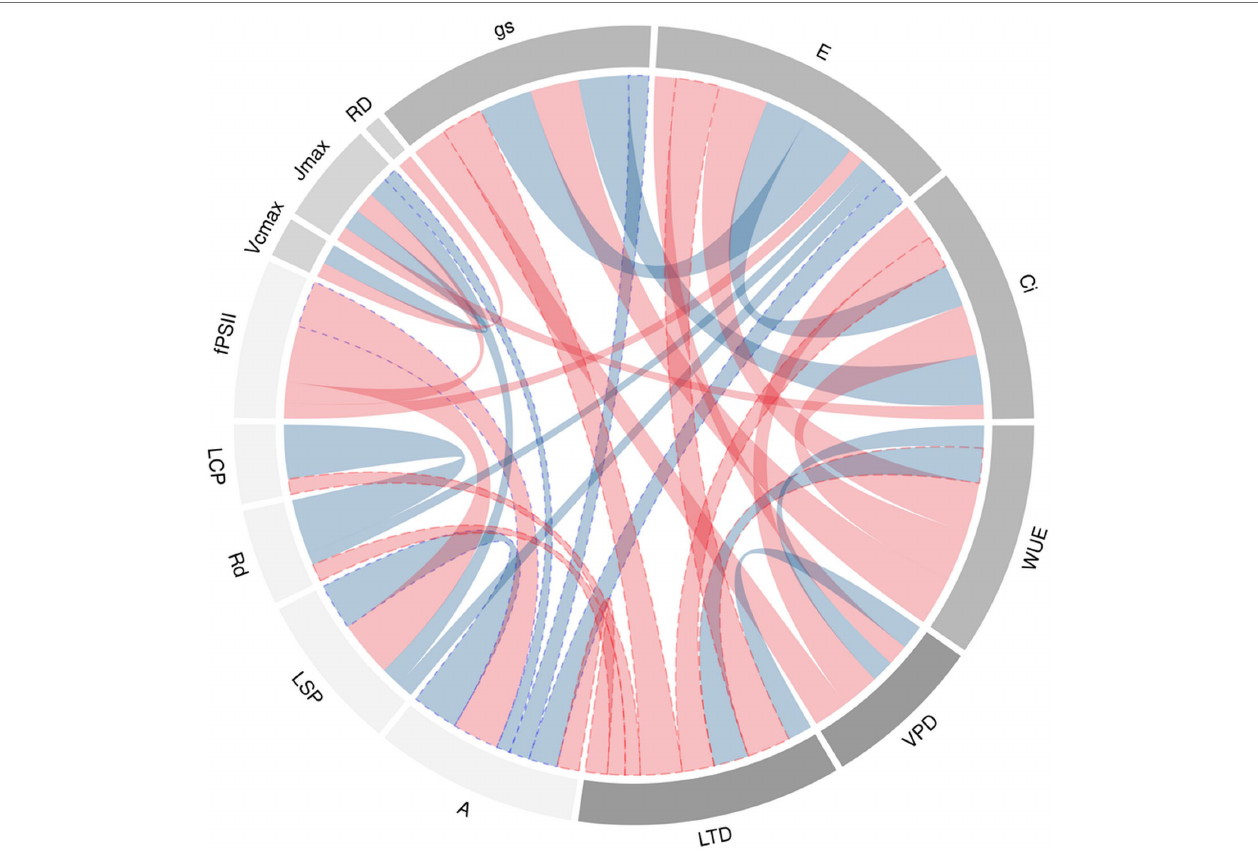
FIGURE 4 | Chord diagram of correlation coefficients between agronomic and physiological traits at leaf level of 64 genotypes of bean grown under conditions of high temperatures. The ribbons within the circle correspond to significant correlations with a p < 0.05. The red ribbons indicate negative coefficients and the blue ribbons indicate positive coefficients. The ribbons with blue and red dotted lines are the relationship of A and LTD to the different variables whose correlation was statistically significant. The acronyms are described in Table 1